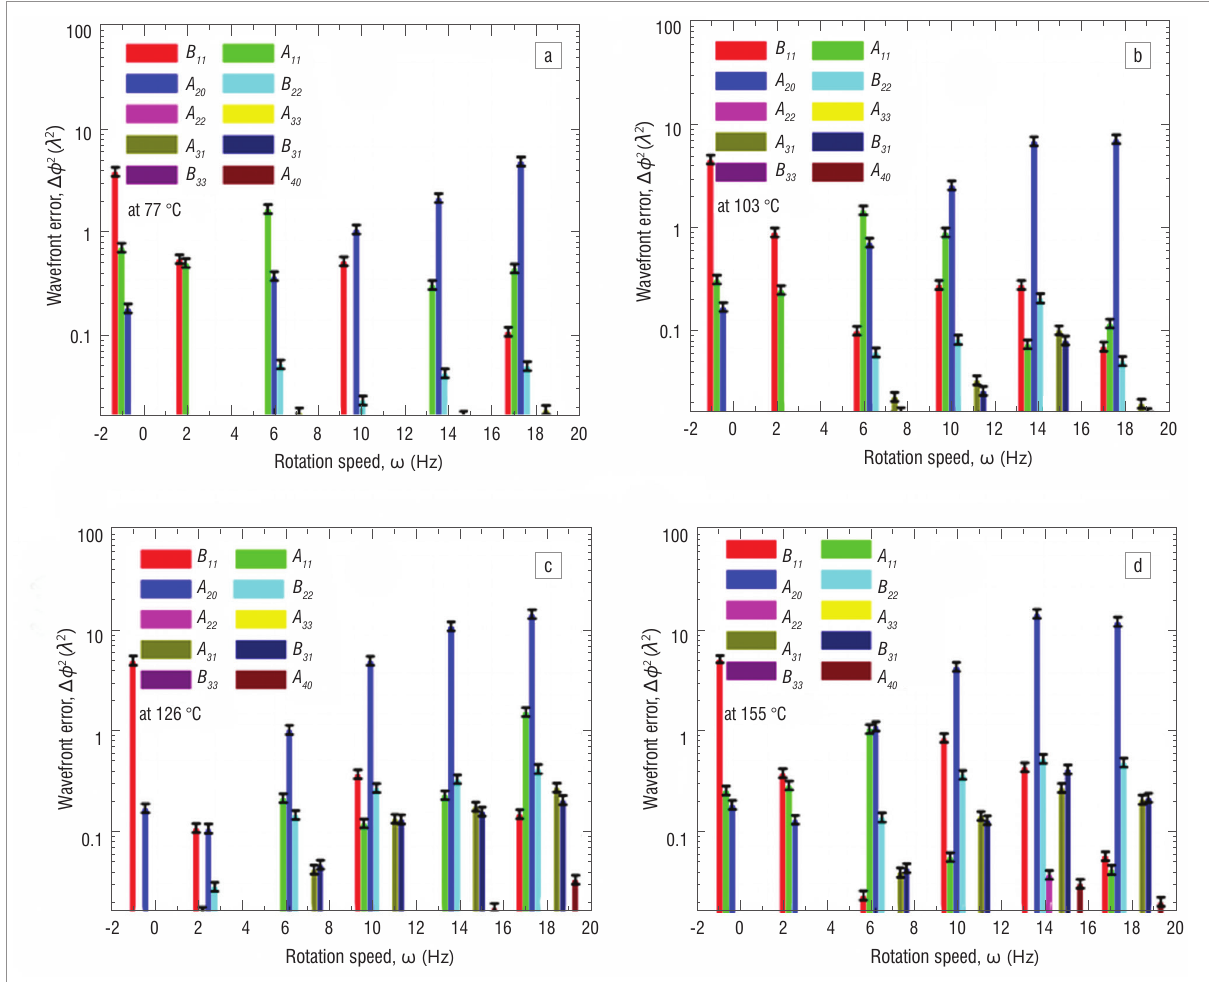
Figure 4: Wavefront error of primary aberration in the spinning pipe gas lens axis at rotation speeds 0 Hz, 2.95 Hz, 6.73 Hz, 10.5 Hz, 14.3 Hz and 18.1 Hz for selected wall temperatures. The Zernike radius was set at 7.28